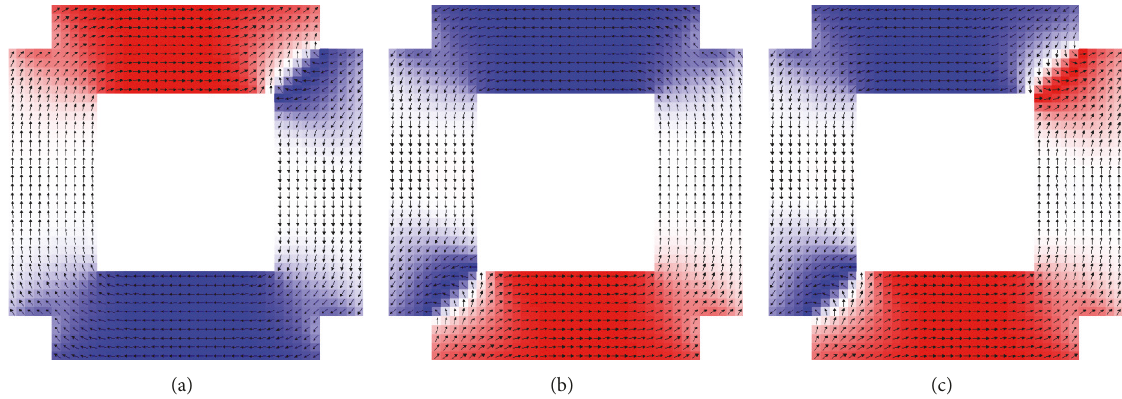
Figure 4: Possible magnetic states for larger angles, simulated in a nanoring with square corner cuts and randomly distributed anisotropy axes: one 360 ∘ domain wall (a), one 360 ∘ domain wall (b), and two 360 ∘ domain walls